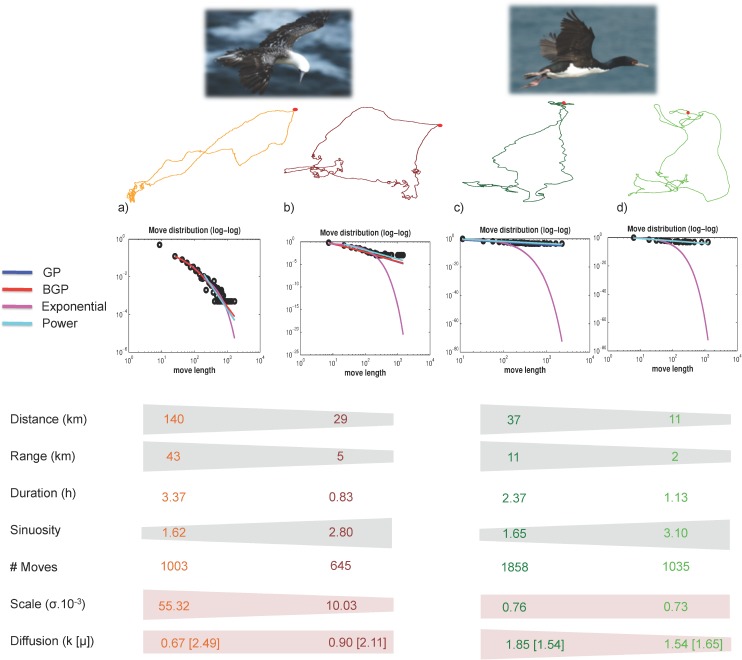
Synoptic characterization of the seabird foraging trips.Original tracks, log-log plots of the fits for the different candidate models and synthetic statistics characterizing the trips: Total distance covered during the foraging trip (km), maximum range from the colony (km), duration of the trip (h), global sinuosity of the trip (defined as distance/2*range), number of moves after resampling (cf. SI S3), scale parameter (σ) and shape parameter (k, describing diffusion) from the fitted BGPD.